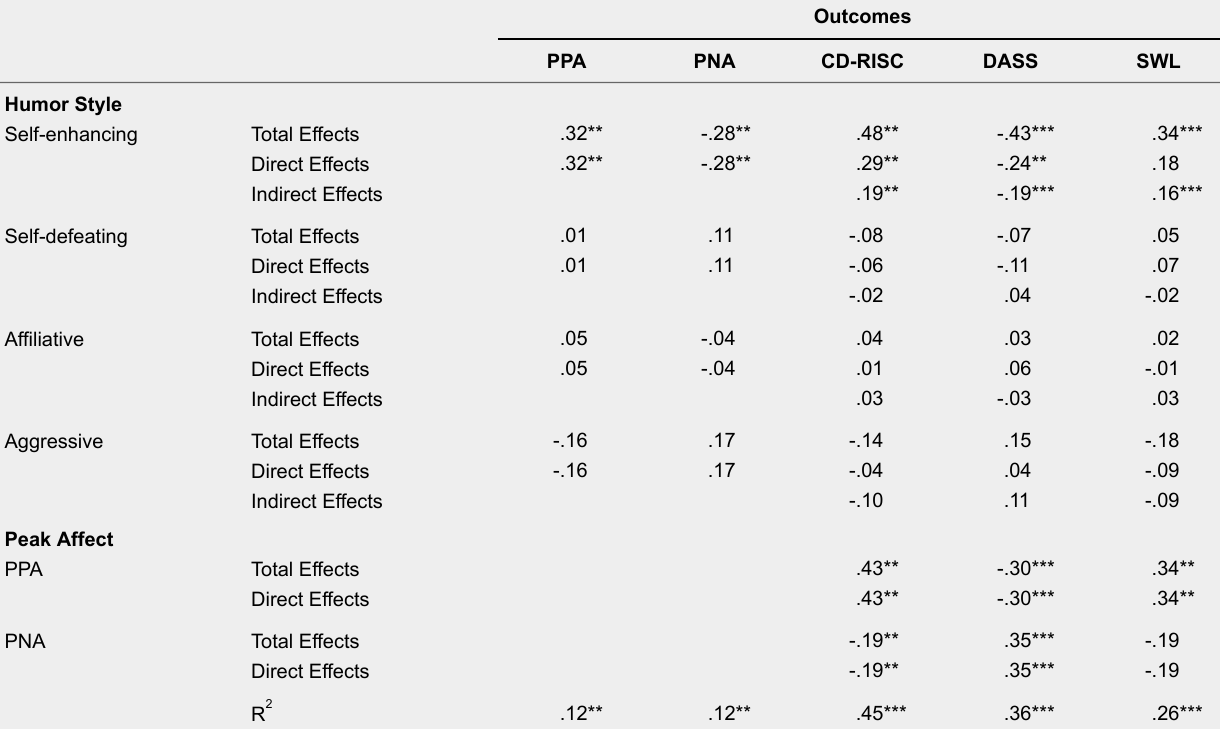
Standardized Effects for all Paths and Variance